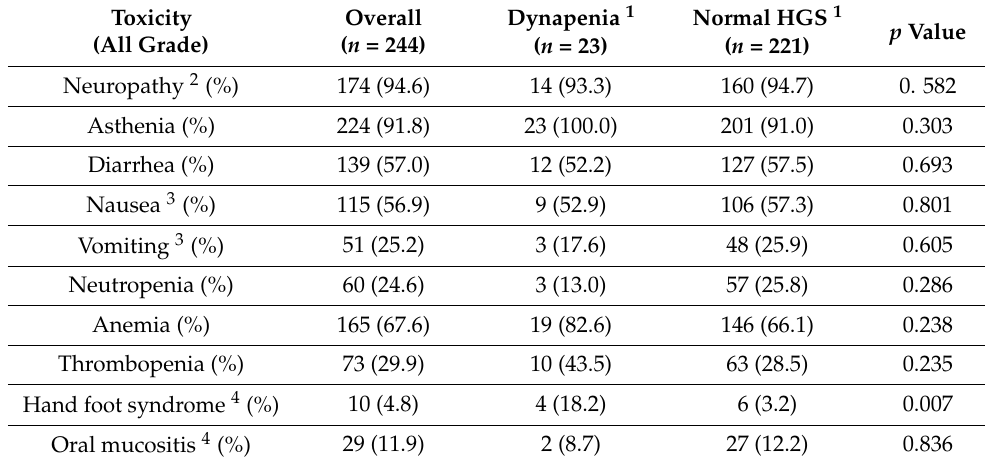
Table 4. Association between dynapenia (original EWGSOP2 criteria) and all-grade chemotherapy- induced toxicities (dose-limiting and not).